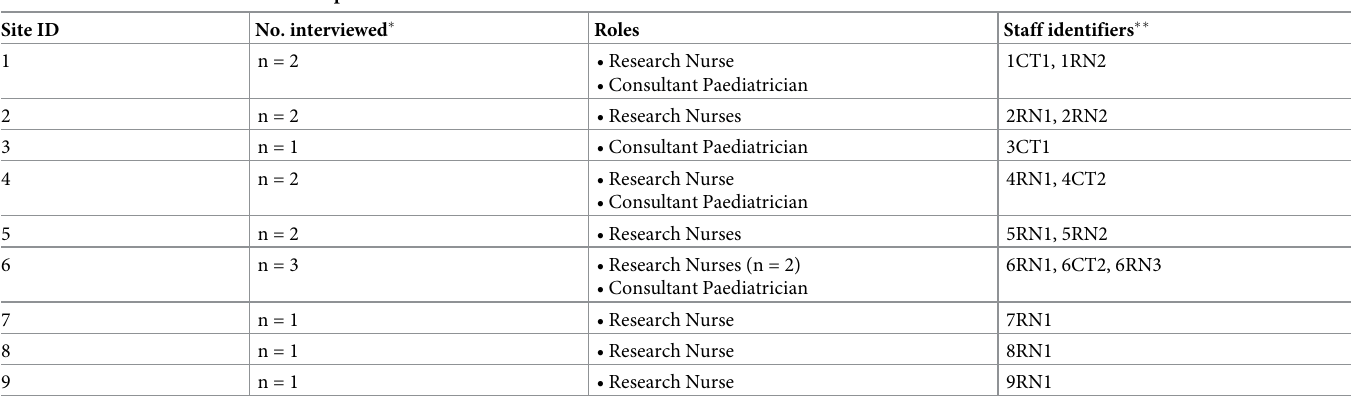
Table 1. Characteristics of our staff sample.